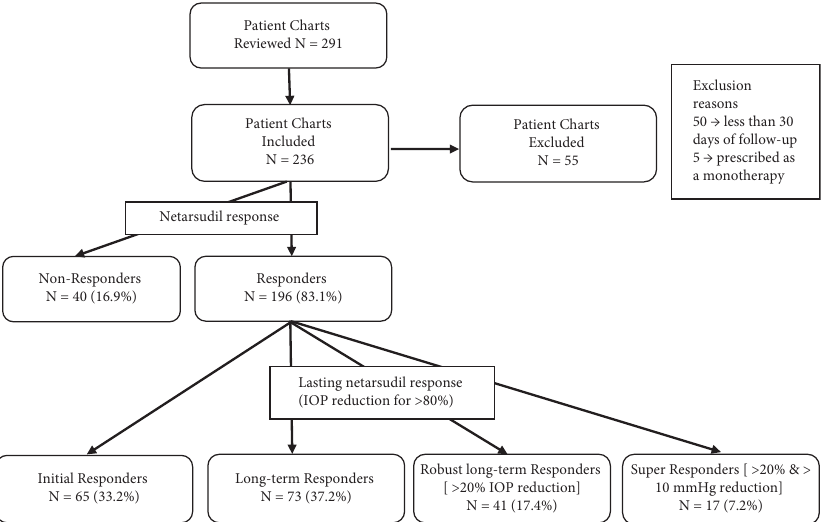
Figure 2: Flowchart of subject inclusion and exclusion in this study and categorization of subjects depending on their response to